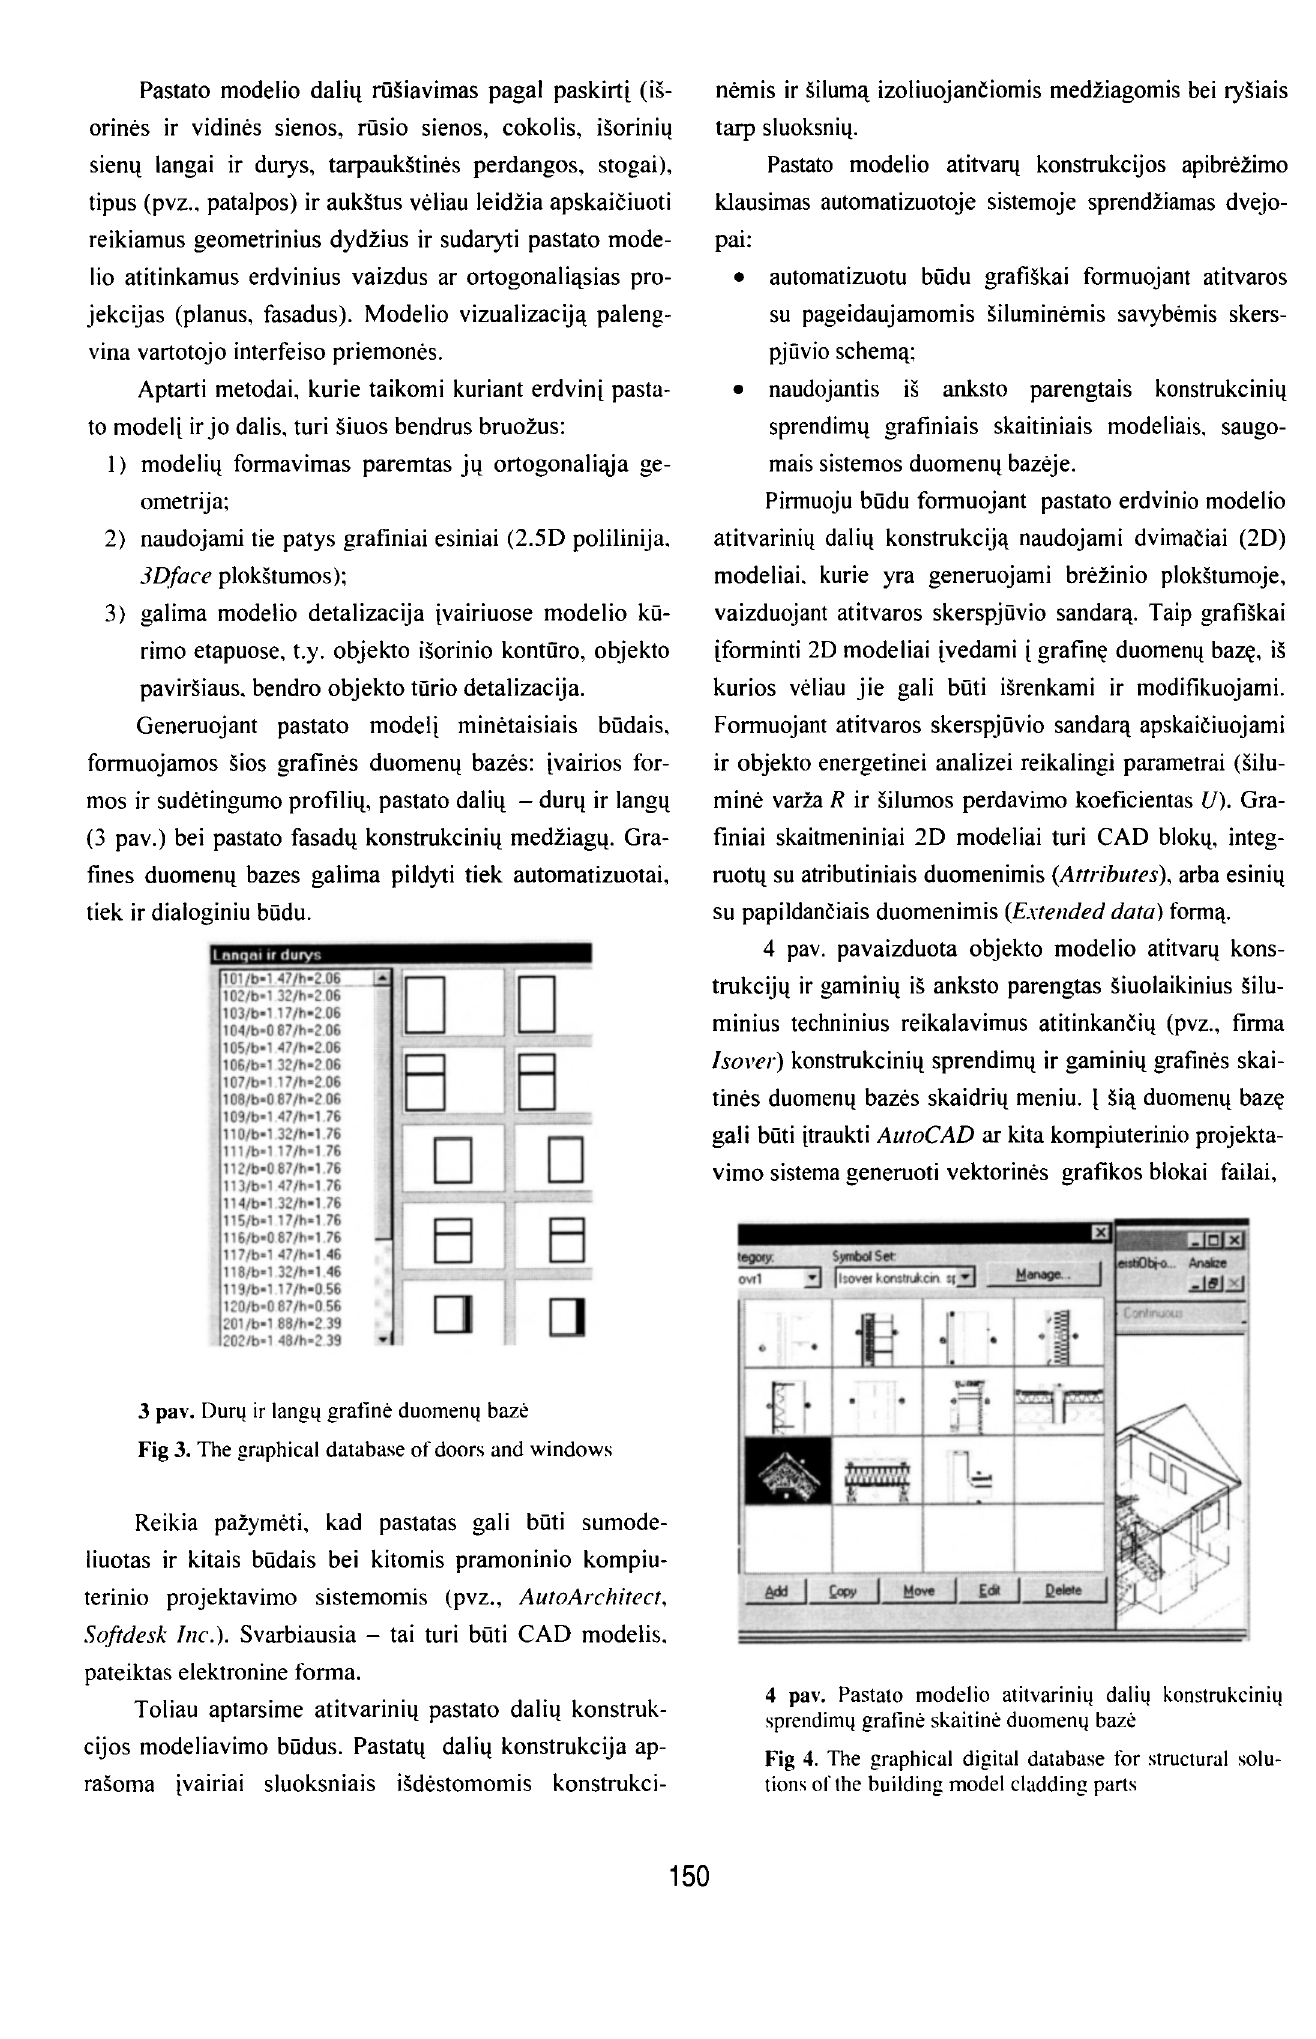
Fig 4. The graphical digital database for structural solu tions of the building model cladding